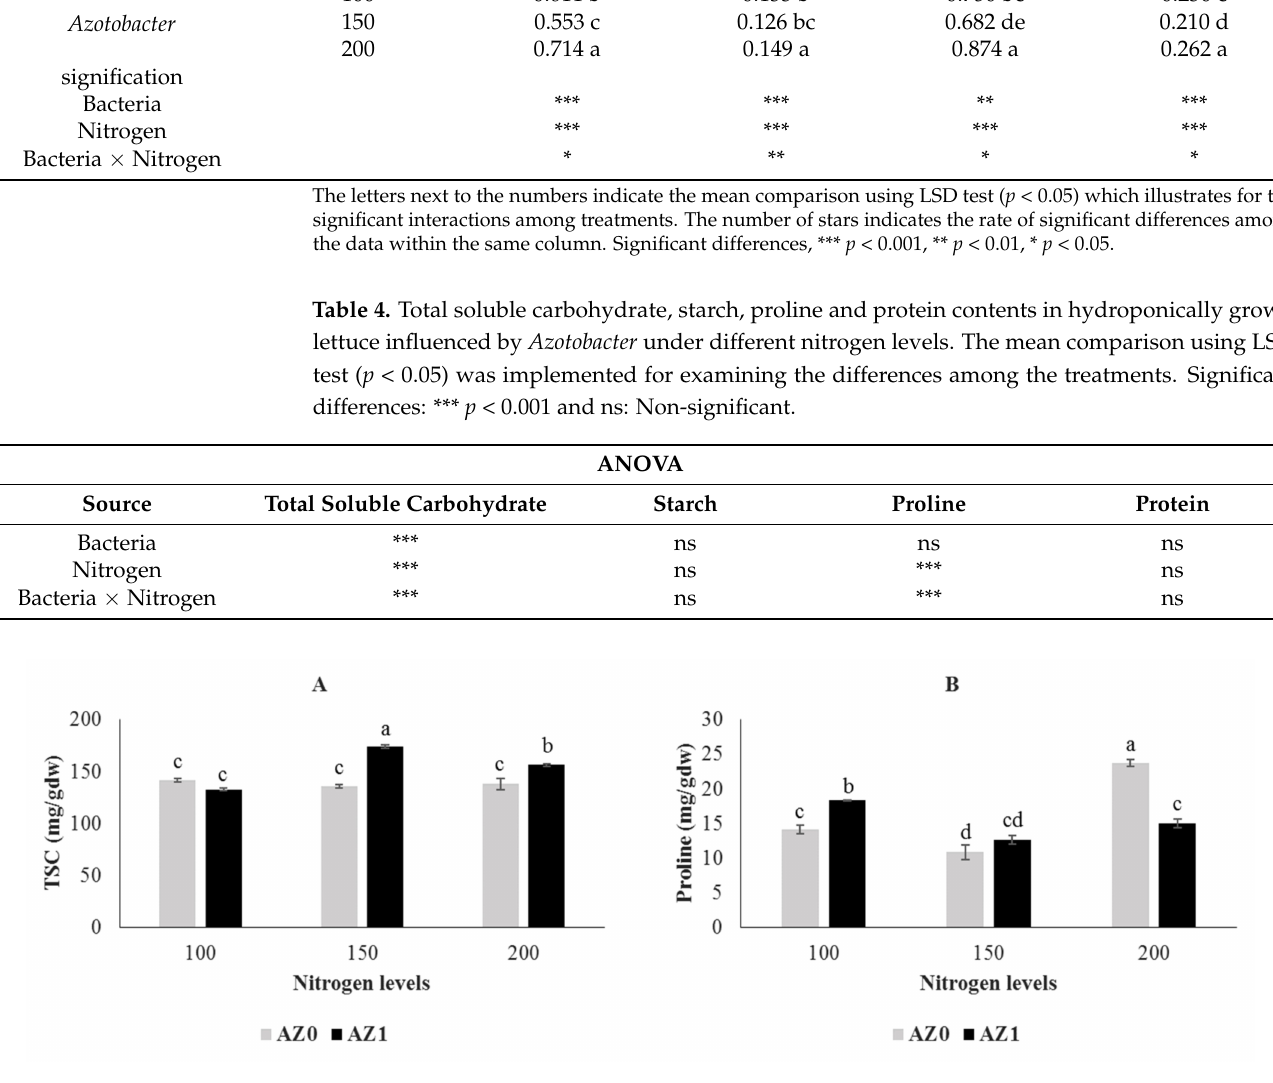
Figure 3. Total soluble carbohydrate (TSC) ( A ) and proline ( B ) contents in hydroponically grown lettuce influenced by Azotobacter under different nitrogen levels. The letters indicate the mean comparison using LSD test ( p < 0.05) which was implemented for examining the differences among the